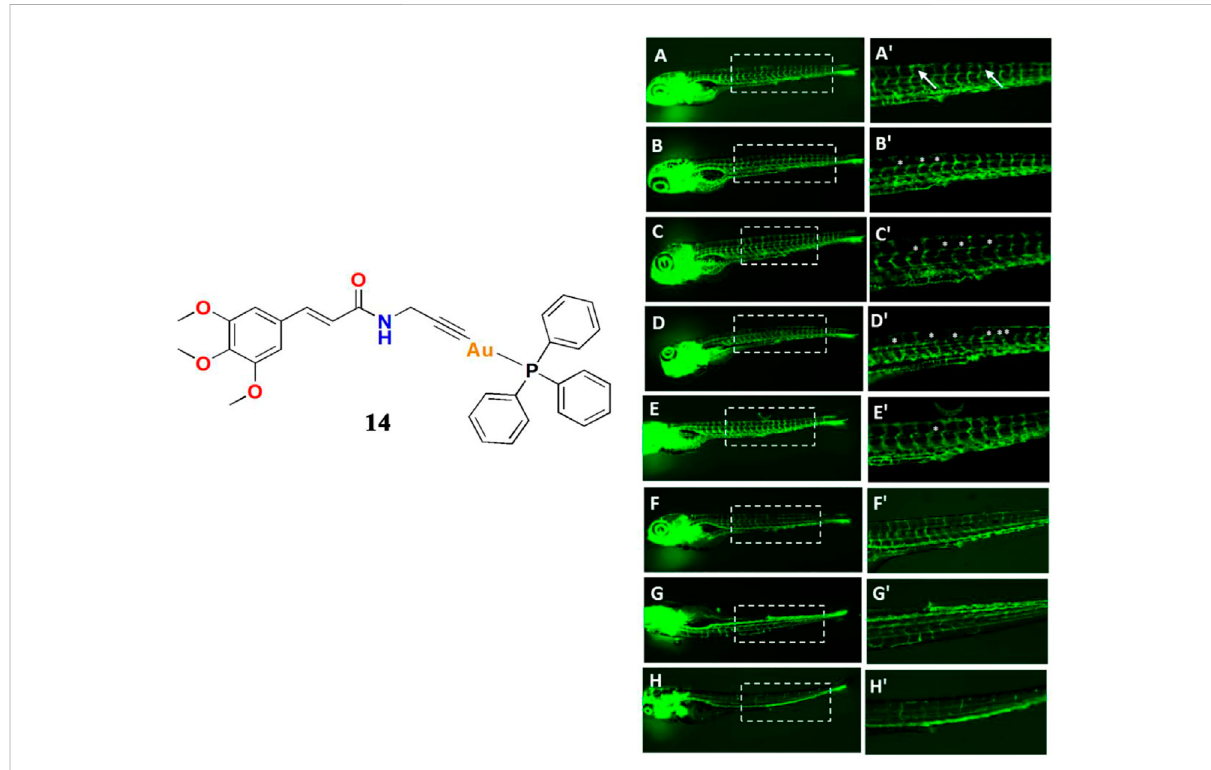
FIGURE 8 Angiogenesis inhibition in transgenic Tg ( fl i1a:EGFP) zebra fi sh embryos after treatment with different concentrations of complex 14 , with cisplatin and axitinib as positive controls, at 24 hpf. (A, A 9 ) control (B − D, B 9 − D 9 ) complex 14 at 0.1/0.25/0.5 μ M (E,E 9 ) cisplatin (1 μ M) (F − H, F 9 − H 9 ) axitinib at 0.1/0.2/0.5 μ M concentrations. Reproduced with permission (Bhargava et al.,